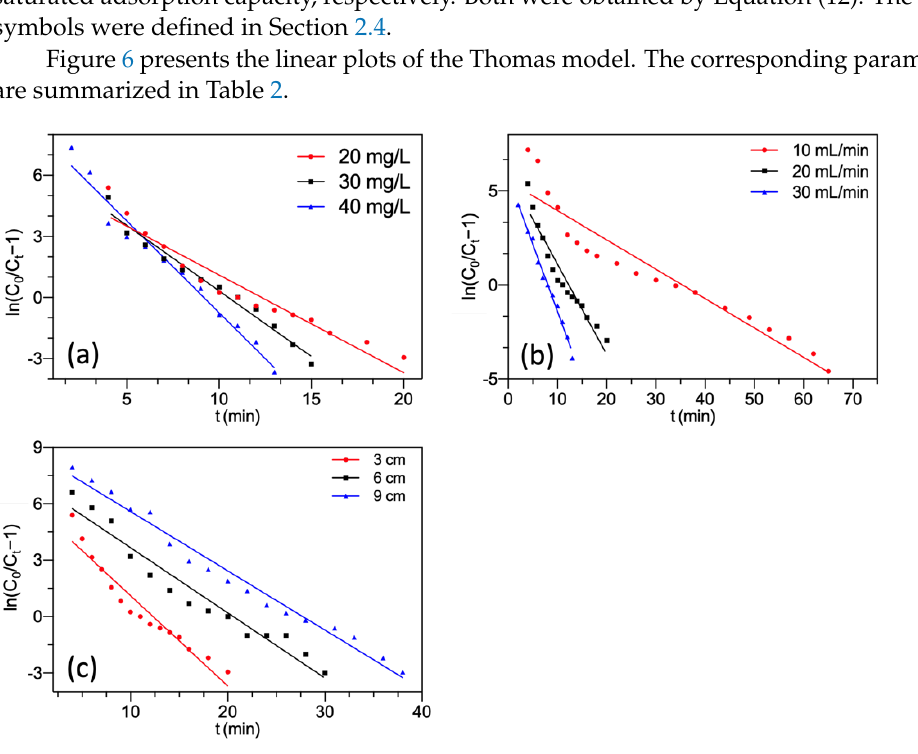
Figure 6. Thomas model fitting of F − adsorption by FBC varying ( a ) F − concentration; ( b ) flow rate; ( c ) bed height. Table 2. Calculated fixed-bed parameters using Thomas model.